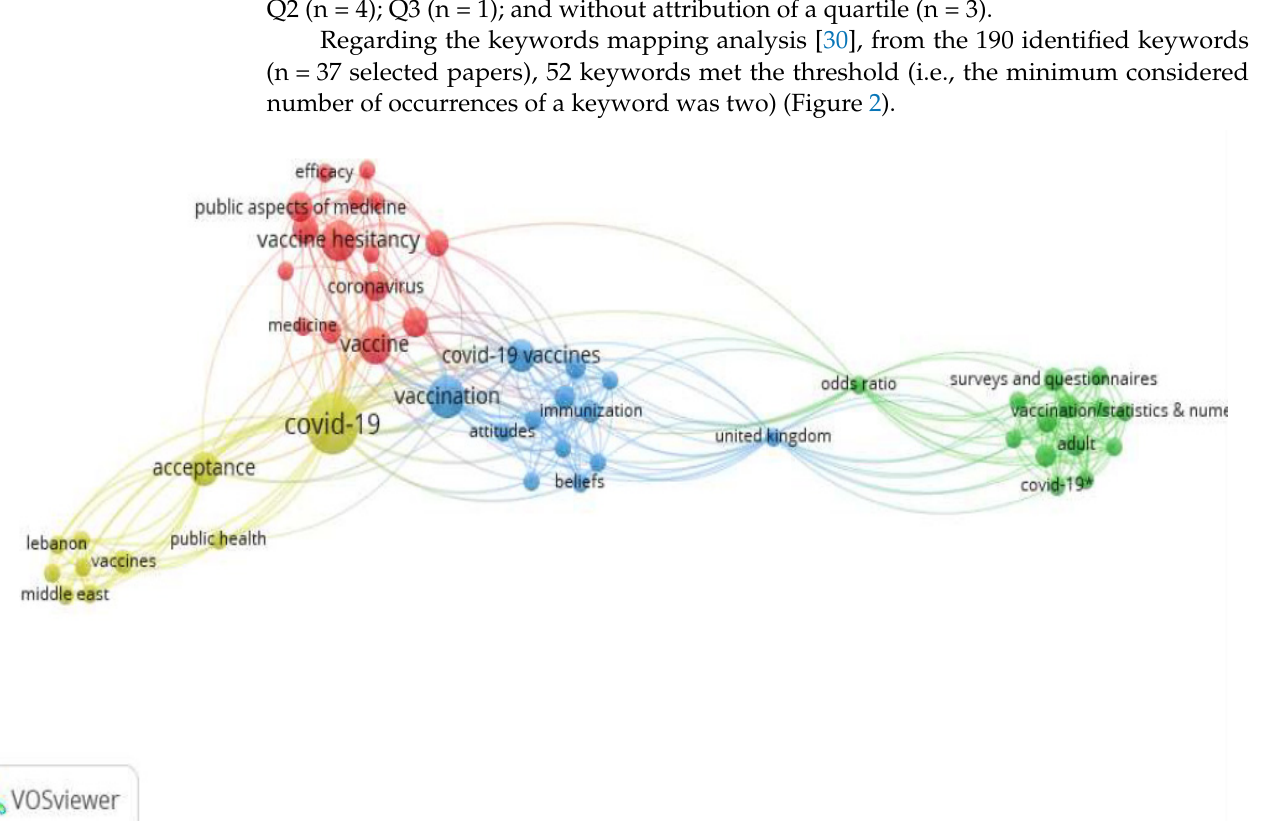
Figure 2. Mapping analysis of keywords from the 37 selected studies. Overall, 233 authors were involved in the 37 selected papers, of which only 19 authors were connected to each other (Figure 3) (mapping analysis of